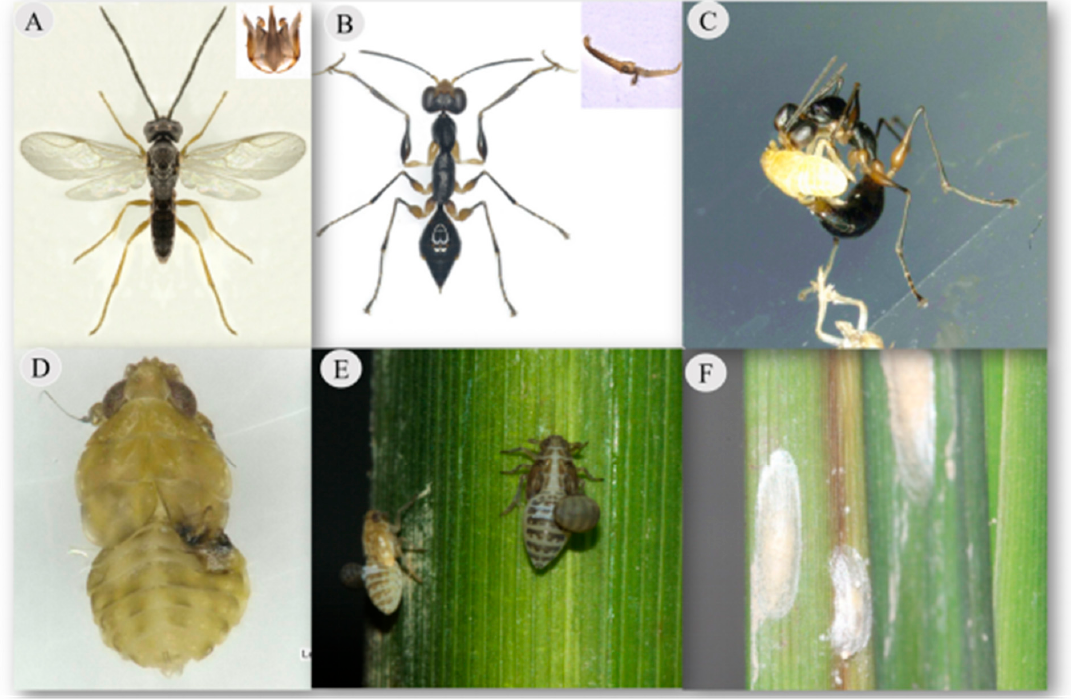
Figure 1. Gonatopus flavifemur (Esaki & Hashimoto, 1932). ( A ) Male and genitalia. ( B ) Female and chela. ( C ) Female with a brown planthopper (BPH) nymph. ( D ) Nymph after being fed upon by G. flavifemur . ( E ) Larval sac on a BPH nymph. ( F ) G. flavifemur cocoon.